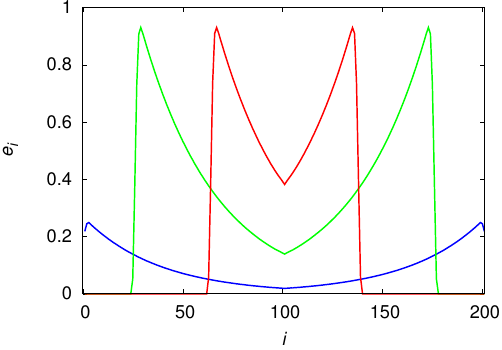
Figure 7. Density of engineers in patch i = 1, . . . , N at times t / N = 0.5 (red line), t / N = 1 (green line) and t / N = 2 (blue line). The chain size is N = 201 and the model parameters are r = 1, α = 1, δ = 0.01, ρ = 10 − 5 and µ = 0.9.